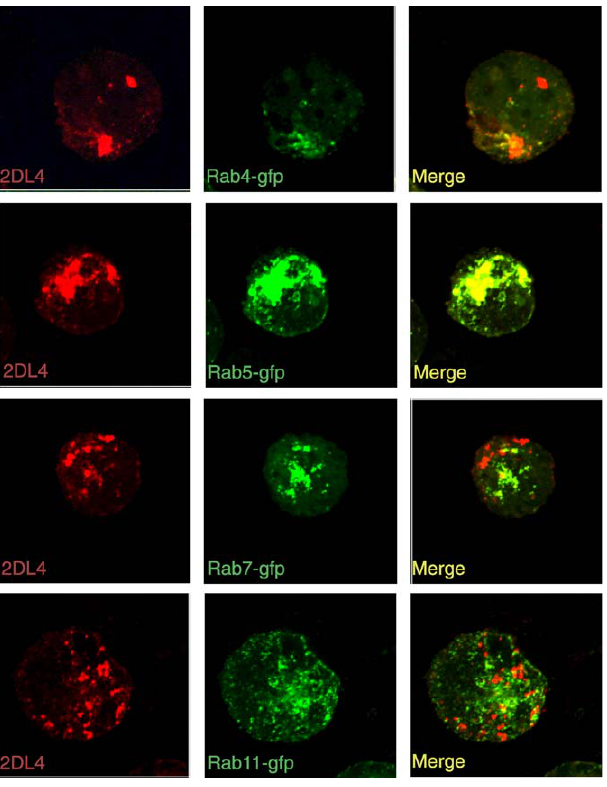
Figure 6. KIR2DL4 Localizes to a Subset of Endosomes Containing Rab5 The 293T cells were transfected with HA-tagged KIR2DL4 and gfp-tagged versions of Rab4, Rab5, Rab7, and Rab11. Forty hours after transfection, cells were fixed and stained with anti-HA mAb, followed by Alexa-568– conjugated secondary antibodies to detect KIR2DL4. Single confocal sections are shown. DOI: 10.1371/journal.pbio.0040009.g006